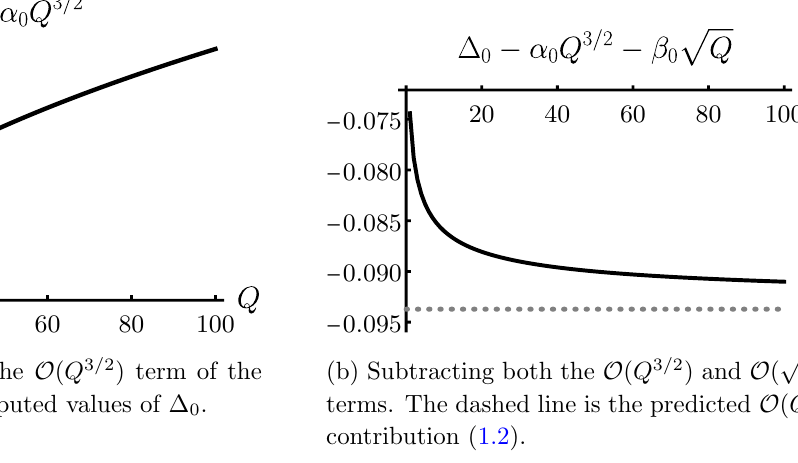
Figure 2. Comparing the (cid:12)t (5.5) with the computed values of (cid:1) 0 (shown in (cid:12)gure